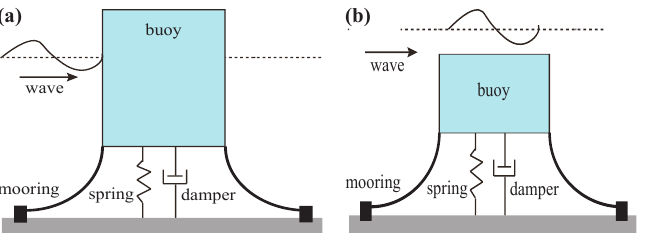
Figure 3. The working principles of floating and submerged one-body point absorbers are illustrated in ( a , b ),